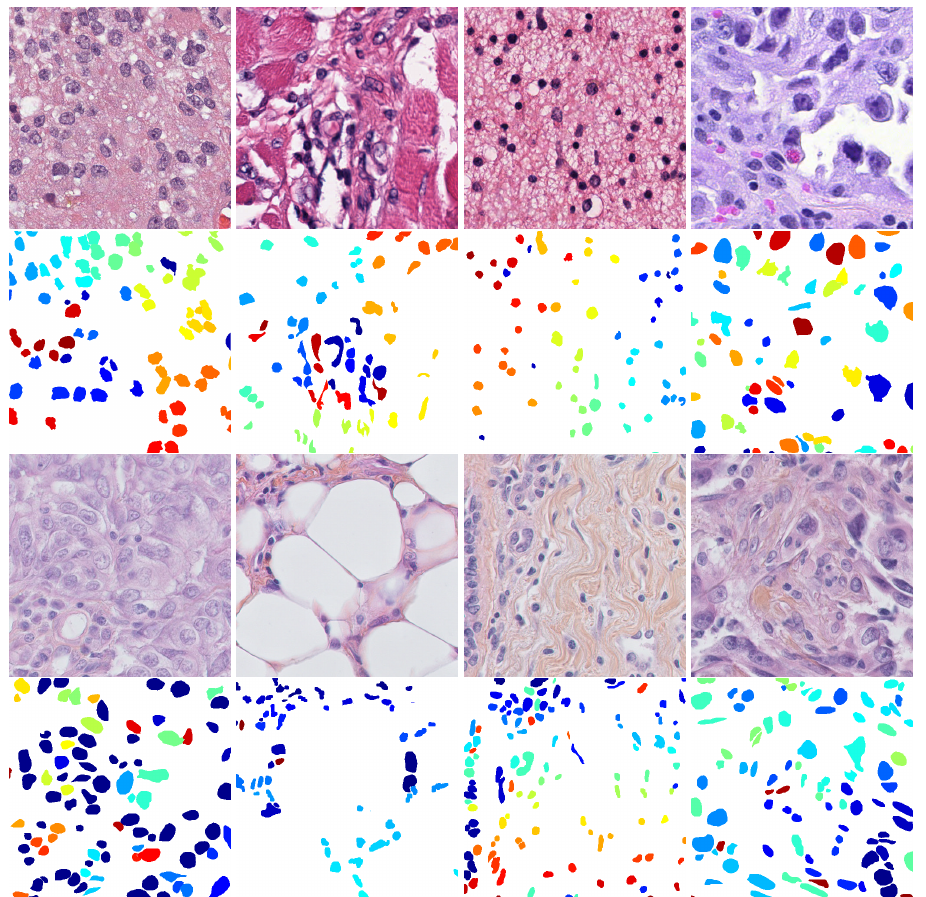
Figure 2. Example of the images present in the used datasets: on top, the images belonging to MIC17 (GBM, LGG, HNSC and LUSC, respectively), and on bottom, the images belonging to